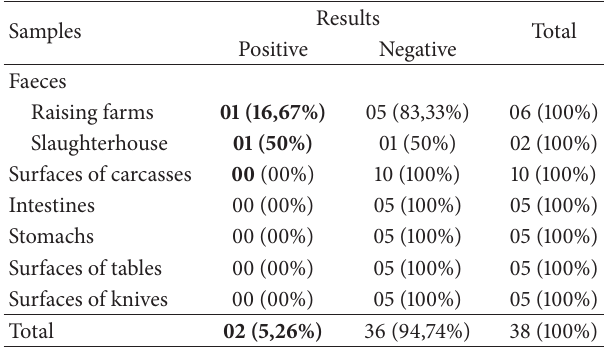
Table 3: Results of analyses of the samples descending from the cattle.